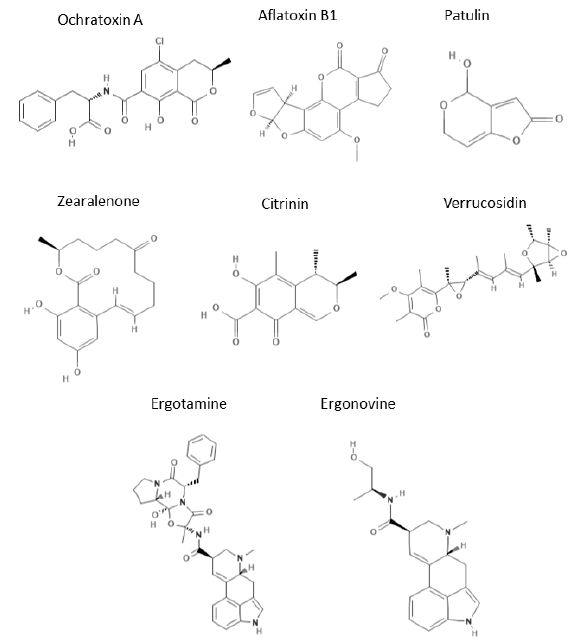
Figure 1. Chemical structures of mycotoxins analyzed by Capillary Electrophoresis (CE) techniques.